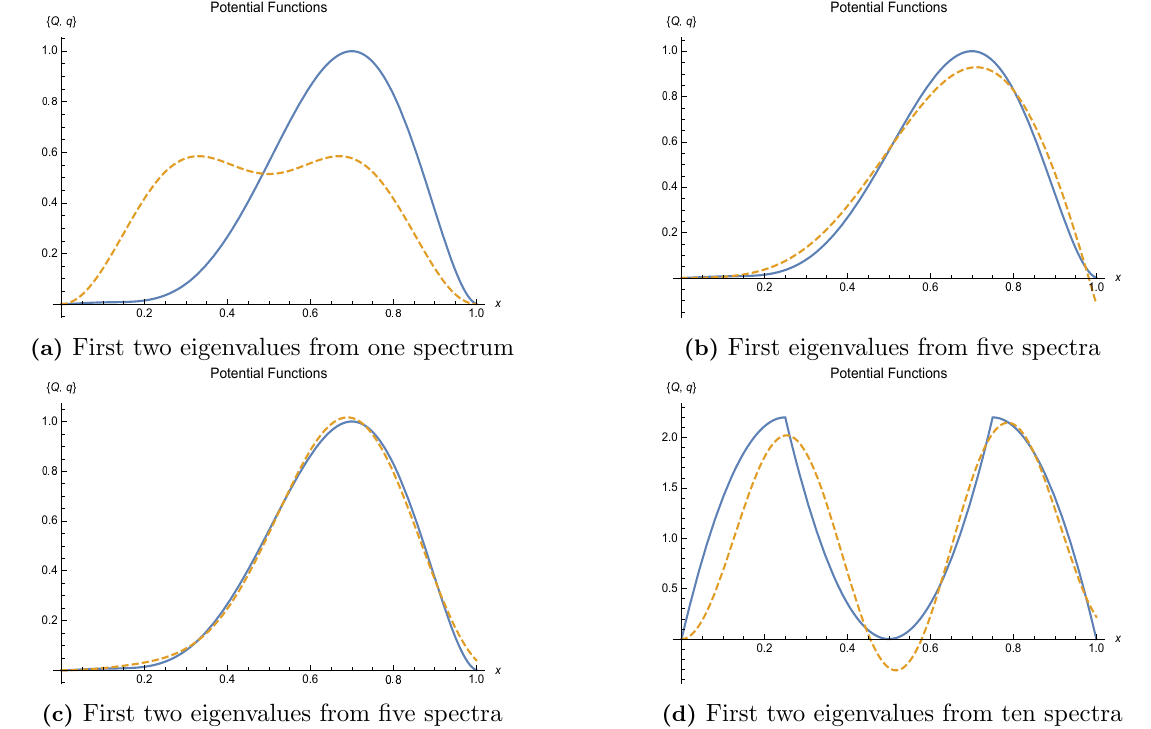
Figure 3. The graphics obtained for Q 1 ( x ) in (a), (b), (c) and Q 2 ( x ) in (d).